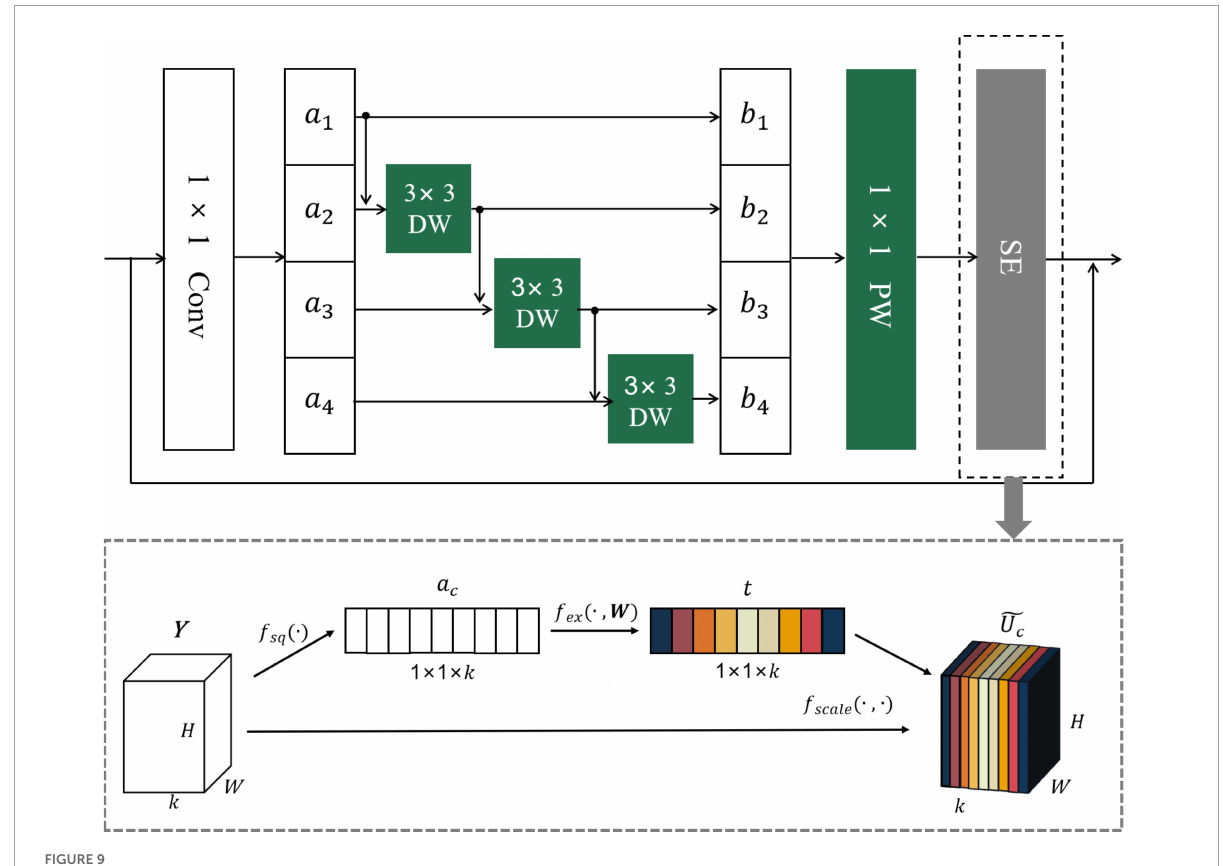
FIGURE9 Working principle diagram of MCF